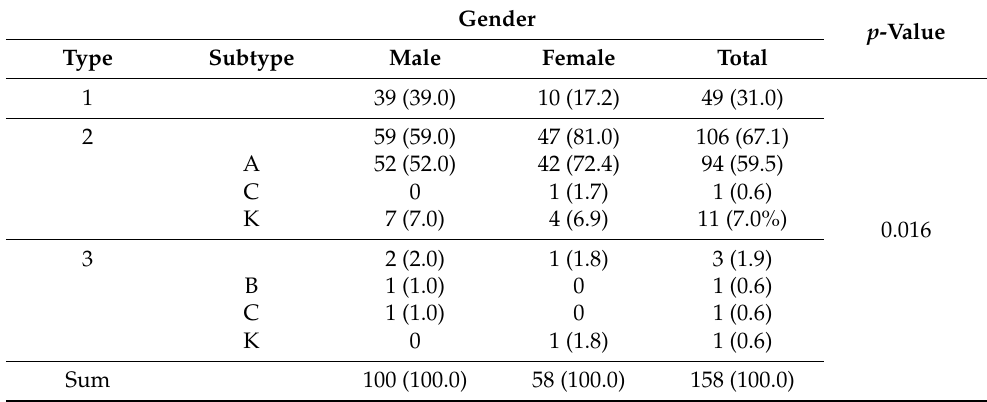
Table 1. Distribution of types according to the gender ( n = 158).